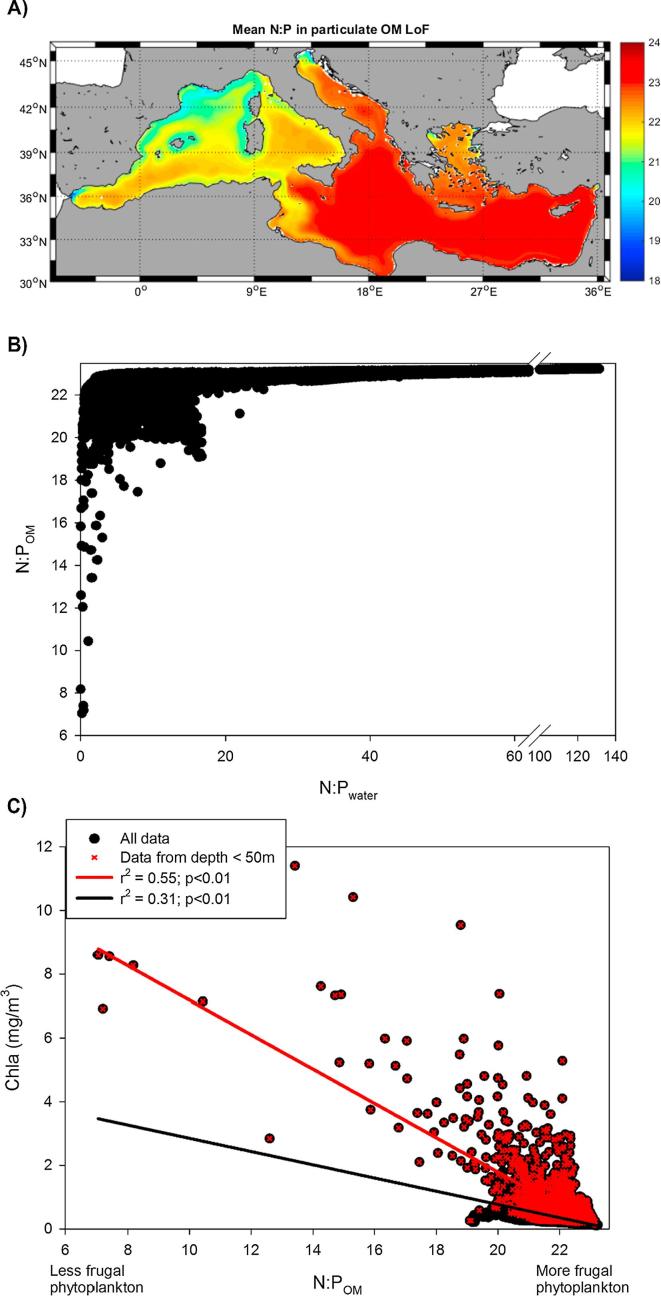
(A) Mean climatological molar N:P ratio in organic matter (OM) for the LoF simulation. (B) Scatter plot of N:P in the organic matter versus N:P in water for the LoF simulation. (C) Scatter plot of chlorophyll concentration versus N:P ratio in the organic matter for the LoF simulation.